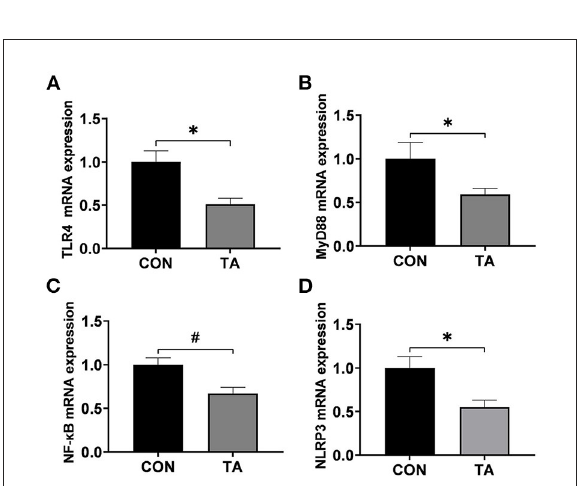
FIGURE5 Effects of dietary supplemented with microencapsulated TA from Galla Chinensis on inflammatory genes in live of broiler chickens. (A) Toll-like Receptor 4 ( TLR4 ), (B) Myeloid differentiation primary response 88 ( MyD88 ), (C) Nuclear factor-kappa B ( NF- κ B ), (D) NLRs family pyrin domain containing 3 ( NLRP3 ). CON, broiler chickens fed a basal diet; TA, broiler chickens fed a basal diet supplemented with 300